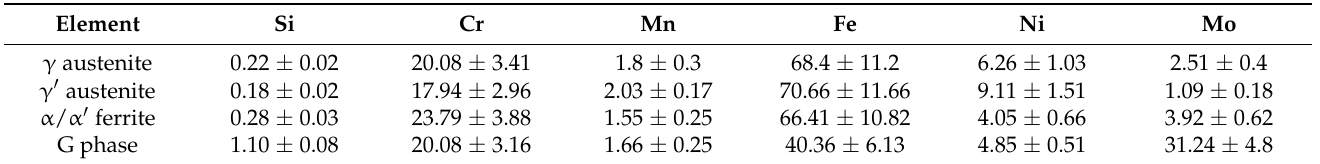
Table 2. Chemical composition of the phases after isothermal fatigue at 600 ◦ C determined by STEM-EDX analyses